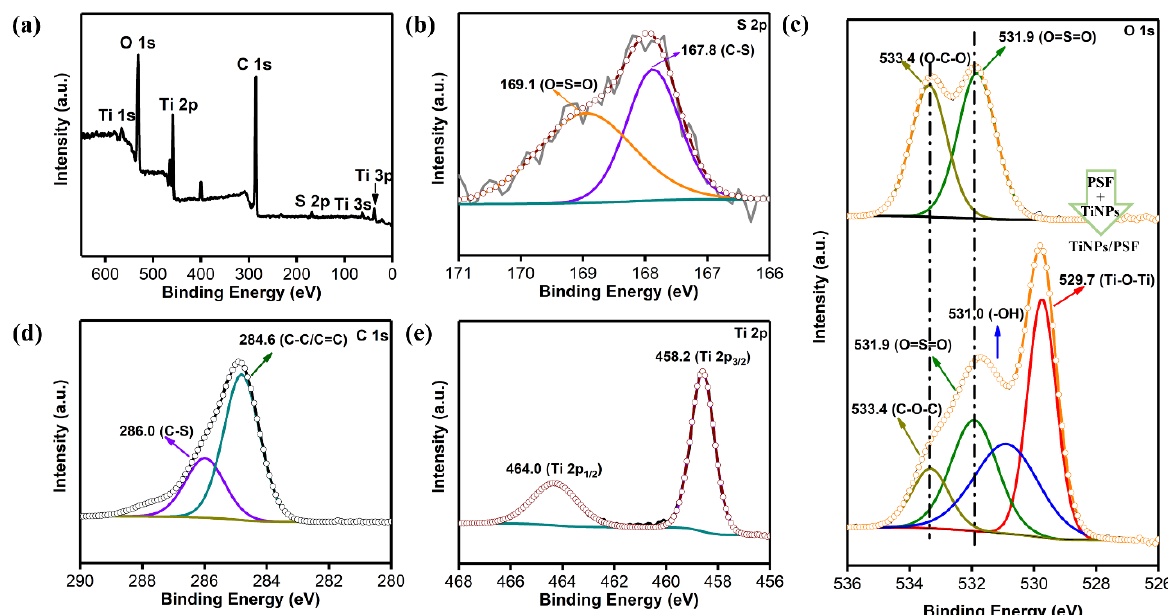
Figure 3. ( a ) X-ray photoelectron spectroscopy (XPS) full-scale spectra of TiNPs/PSF-0.40, peak-fitting XPS of the ( b ) S 2p, ( c ) O 1s, ( d ) C 1s, ( e ) Ti 2p.